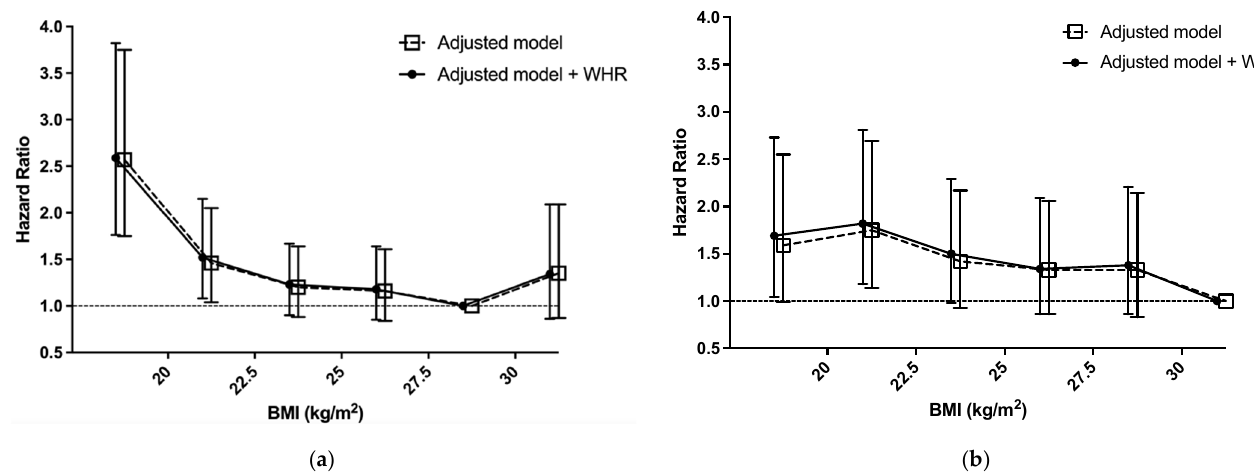
Figure 1. ( a ) HRs for mortality according to BMI in male patients before and after adjustment by WHR; ( b ) HRs for mortality according to BMI in female patients before and after adjustment by WHR. Abbreviations: BMI: body mass index, WHR: waist-to-hip ratio.